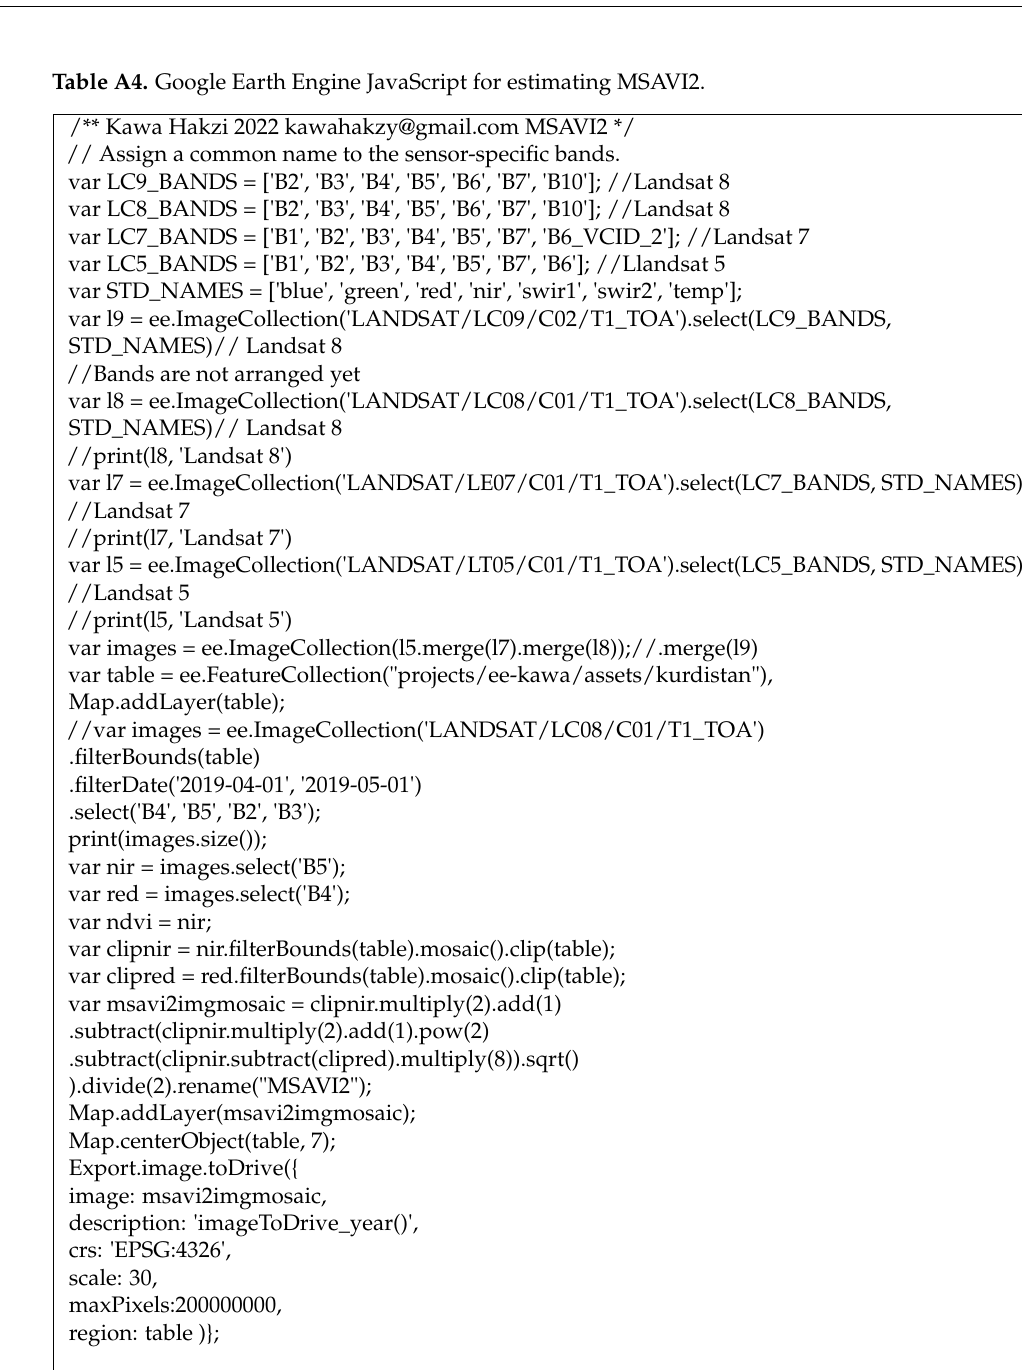
var table = ee.FeatureCollection("projects/ee-kawa/assets/kurdistan"),